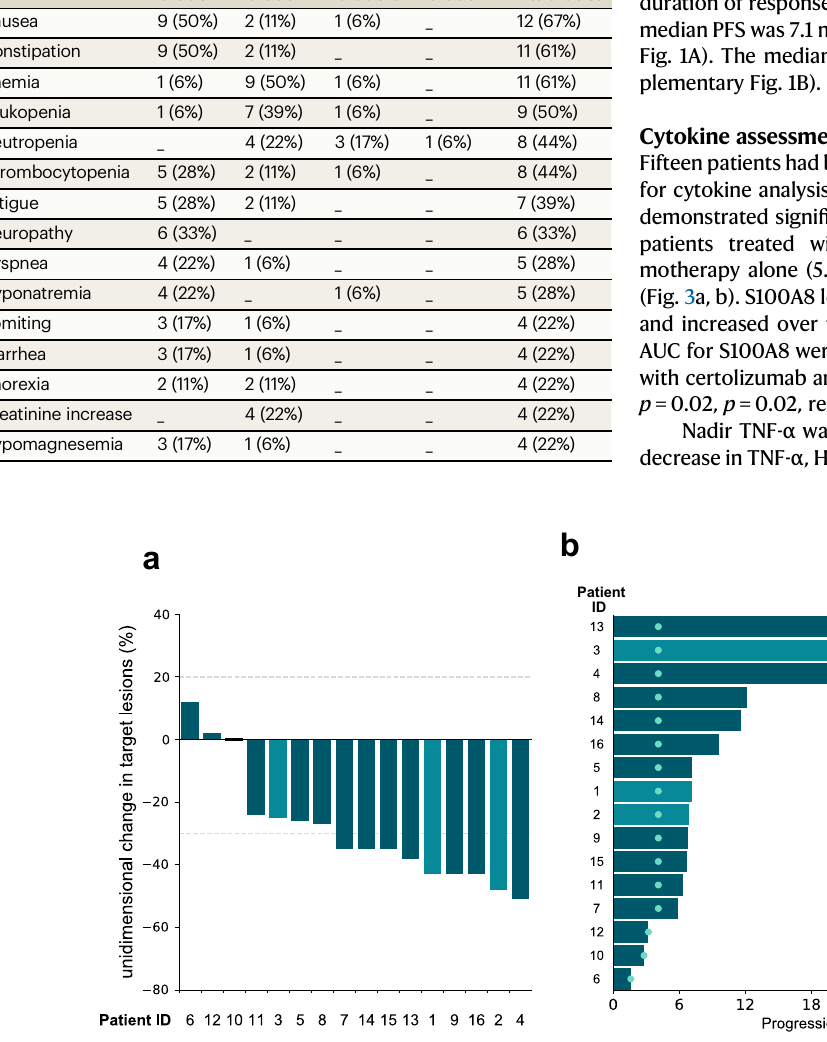
CI 6.30 to NR). Data re fl ects progression in all patients ( n =16) save for patient 13, who was censored at the date of last follow-up. Source data are provided as a Source Data fi